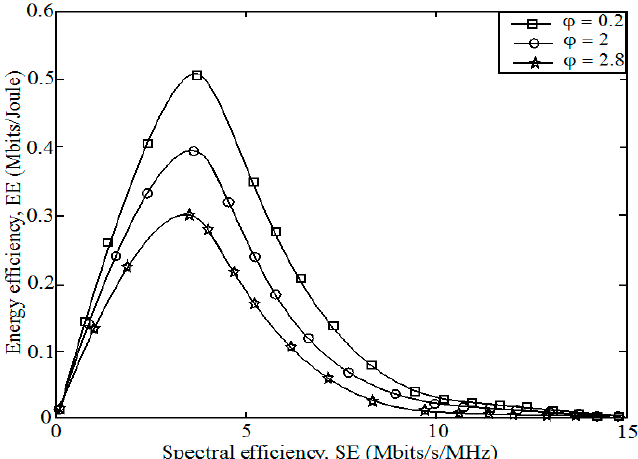
Figure 6. Relationship between SE and EE when the relay power is taken into account in the CCRNs with different relay factors ϕ .